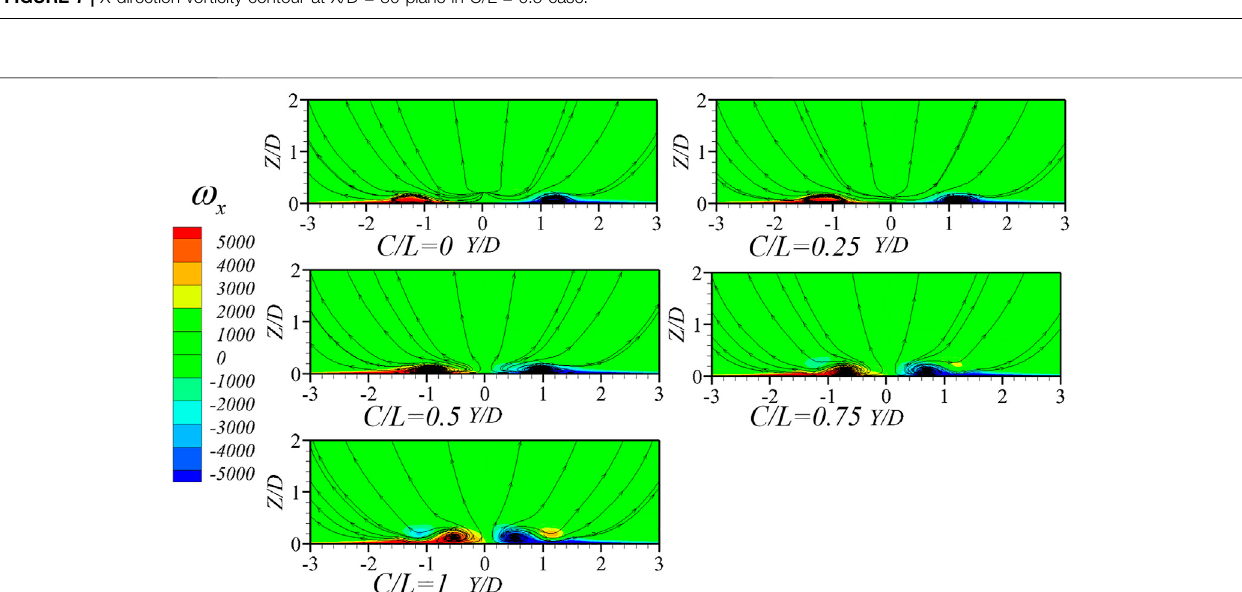
FIGURE 7 | X-direction vorticity contour at X/D (cid:2) 30 plane in C/L (cid:2) 0.5 case.